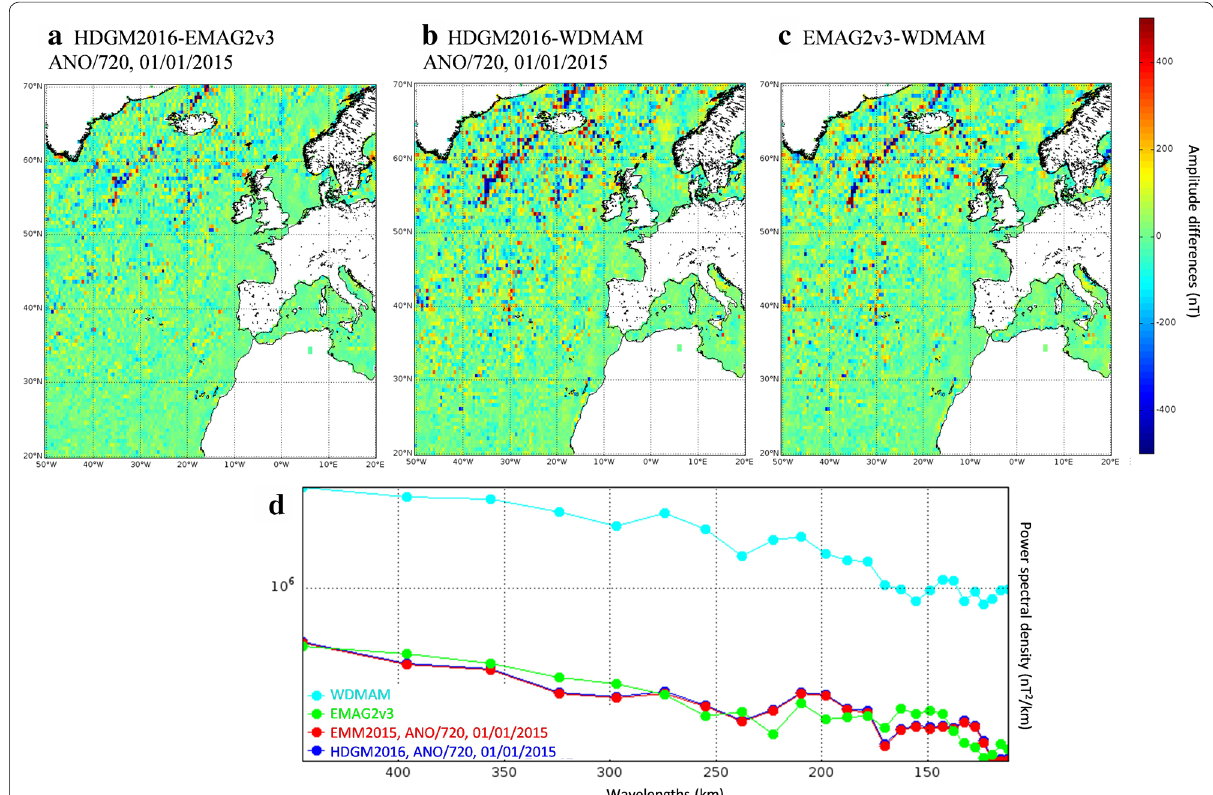
Fig. 7 Comparison of intensity values of the anomaly field (ANO) estimated from HDGM2016 and EMM2015 up to SH degree 720 for the date 01/01/2015, and EMAG2v3 and WDMAM anomaly grids. Maps of differences ( a – c ) and radial power spectral densities ( d ) for the NEAWM area (grid spacing: 0.5°)